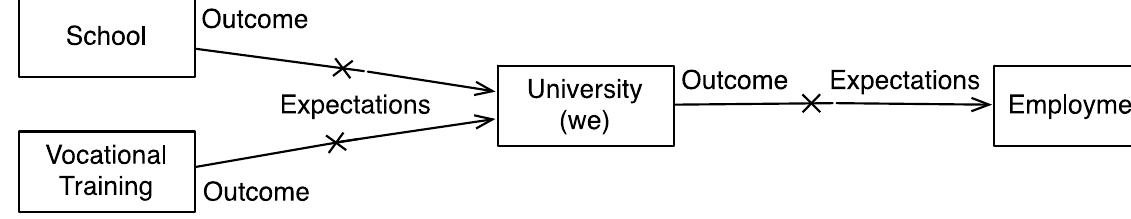
Figure 1. Competence gaps from school or vocational training via university to professional life